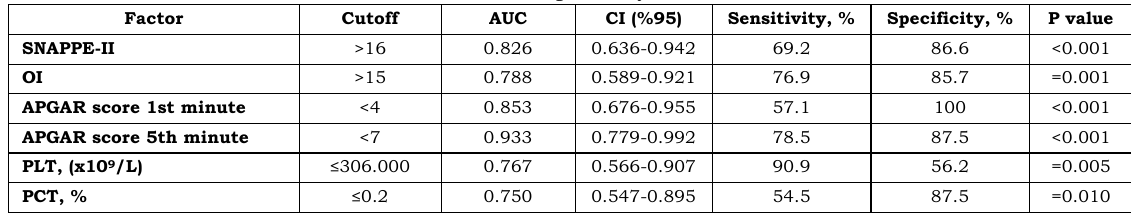
Table 2. Factors Predicting mortality in CDH newborns Factor Cutoff AUC